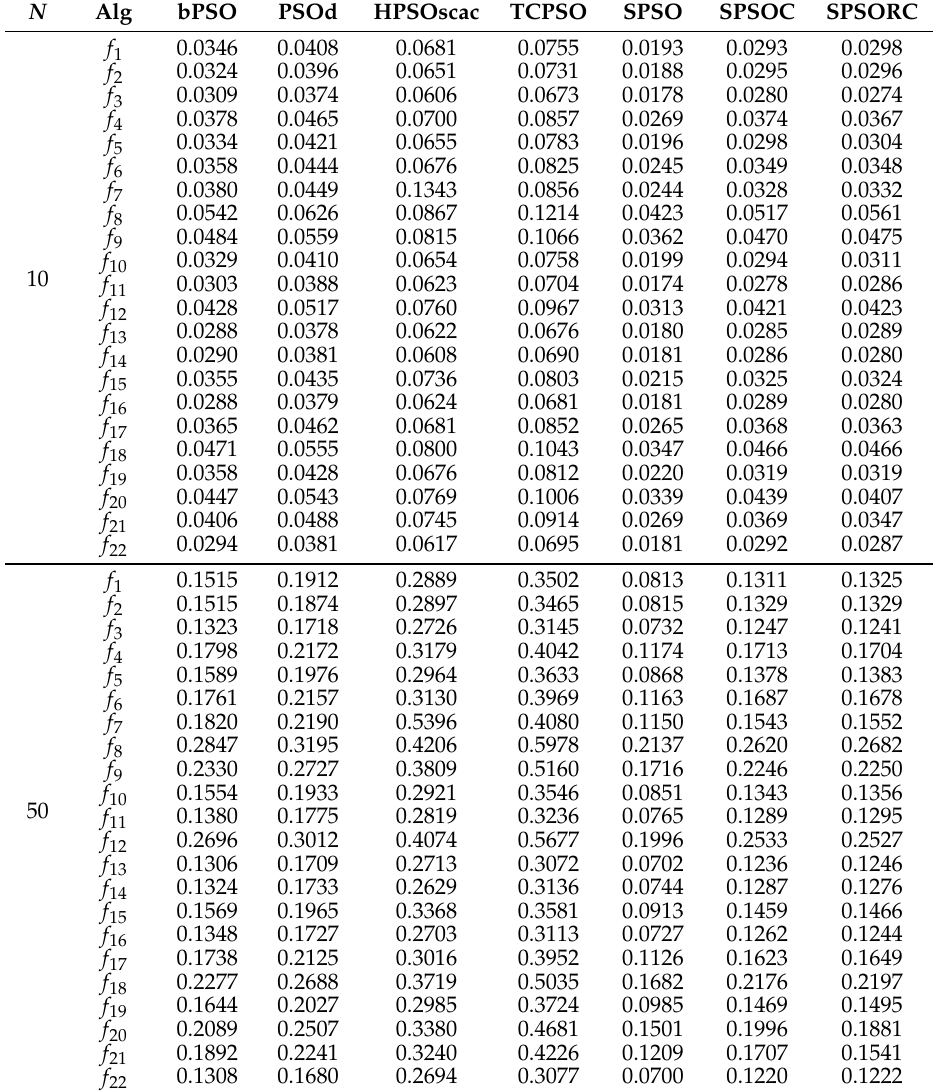
Table 8. Real computational